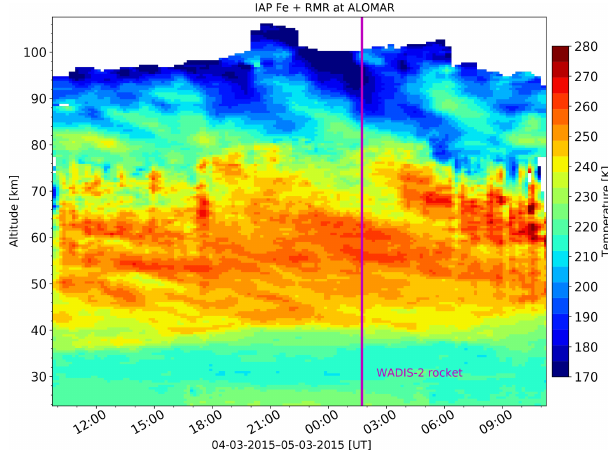
Figure 3. Combined RMR and Fe lidar temperature measurements during the night of the WADIS-2 rocket launch, i.e., 4 to 5 March